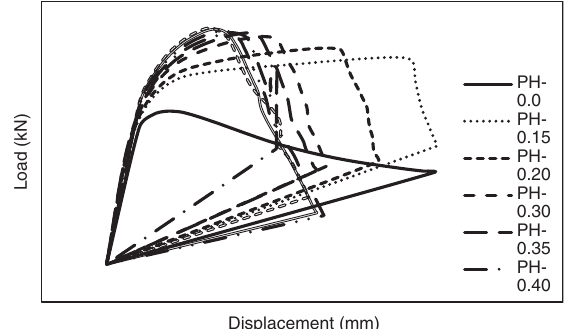
Fig. 8. Load – de fl ection curves series PH